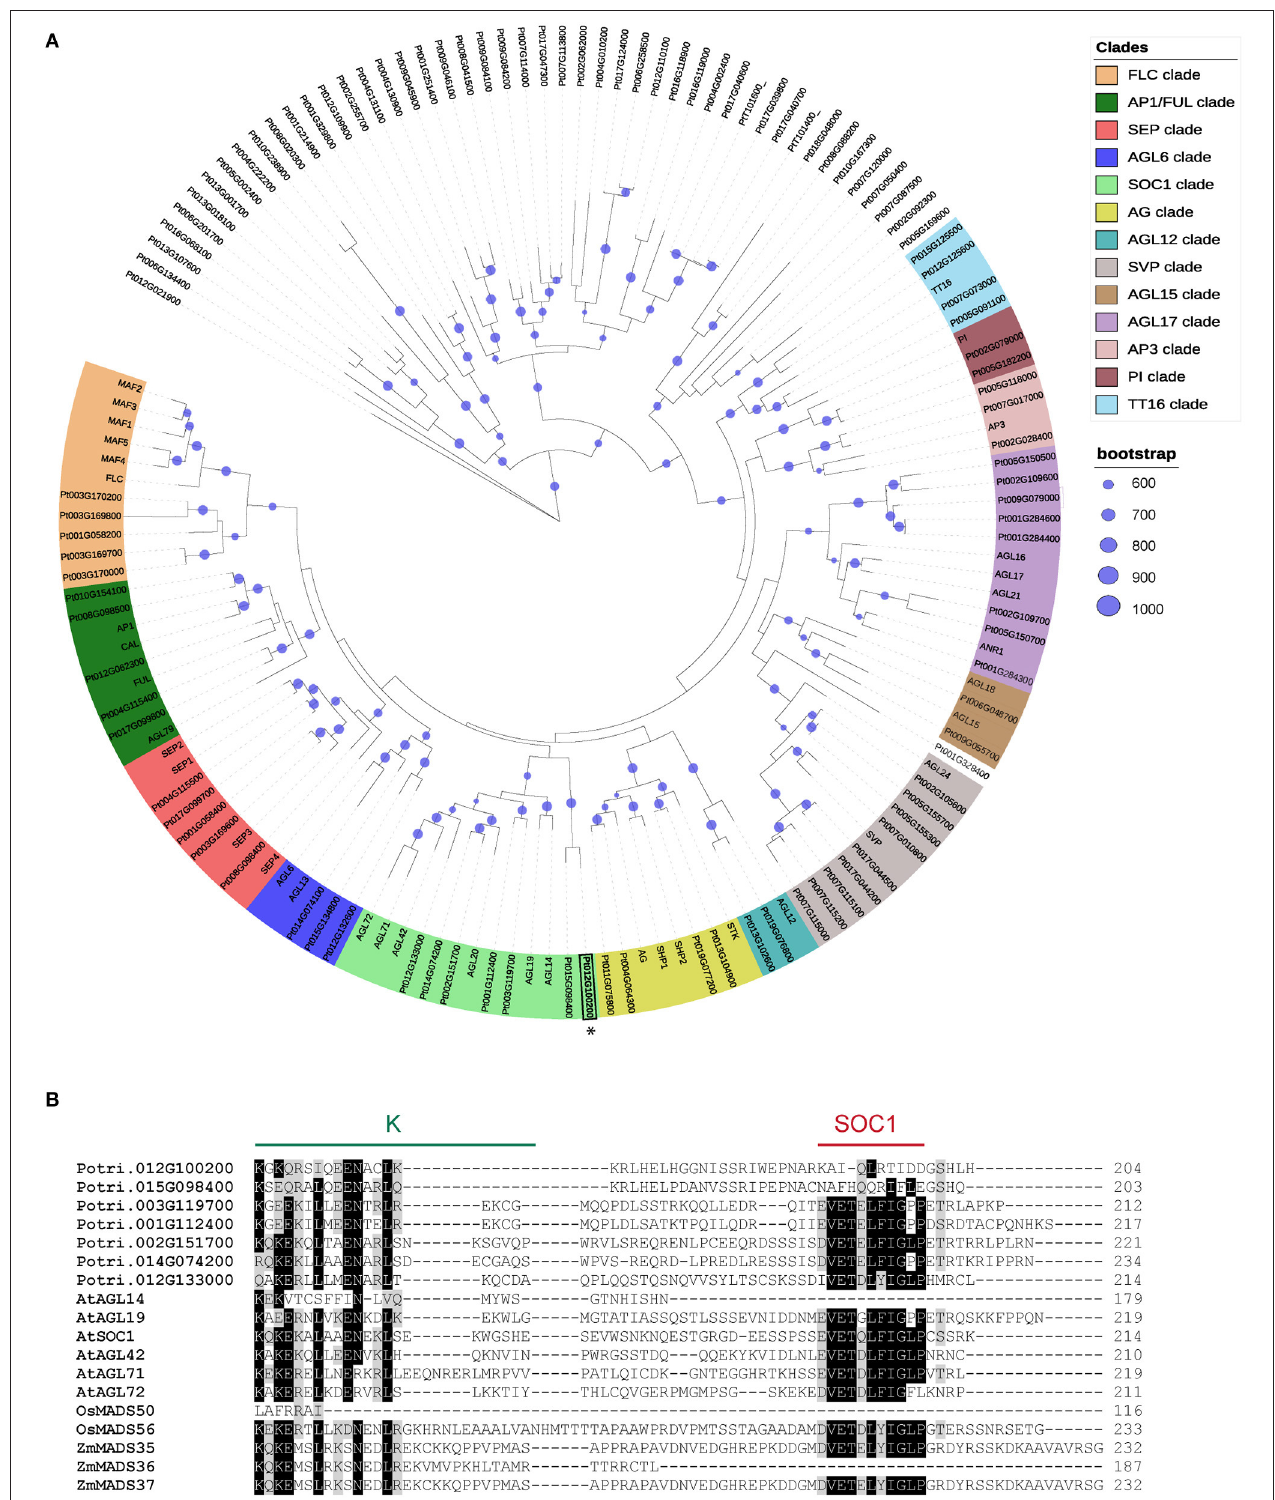
FIGURE 1 | Identification of poplar SOC1-like proteins. (A) Phylogenetic tree analyses of MADS-box proteins from Arabidopsis and poplar. Maximum likelihood tree obtained using the RAxML tool with 1,000 bootstrap replicates. The right panel indicates the color code of the clades and bootstrap values. Clades are named FLOWERING LOCUS C (FLC), APETALA1/FRUITFUL (AP1/FUL), SEPALLATA (SEP), AGAMOUS-LIKE 6 (AGL6), SOC1, AG, AGL12, SVP, AGL15, AGL17, AP3, PISTILLATA (PI), and TRANSPARENT TESTA16 (TT16). (B) MAFF alignment of Populus , Arabidopsis , rice, and maize SOC1-like proteins. The alignment shows part of the K domain (green ink) and the SOC1 motif (red ink). Black boxes indicate identical amino acids. Gray boxes indicate conservative amino acid substitutions.